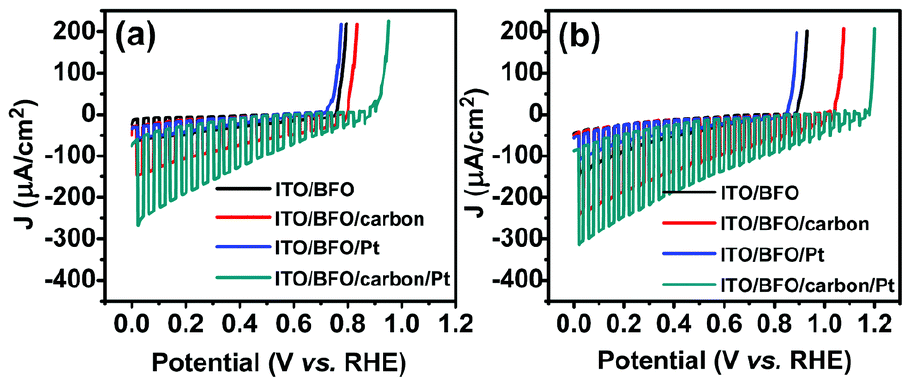
Figure 6. Photocurrent potential (J–V) curves of different BiFeO 3 (BFO)-based photocathodes before ( a ) and after ( b ) positively poling the BFO film [53]. Copyright 2017, Royal Society of